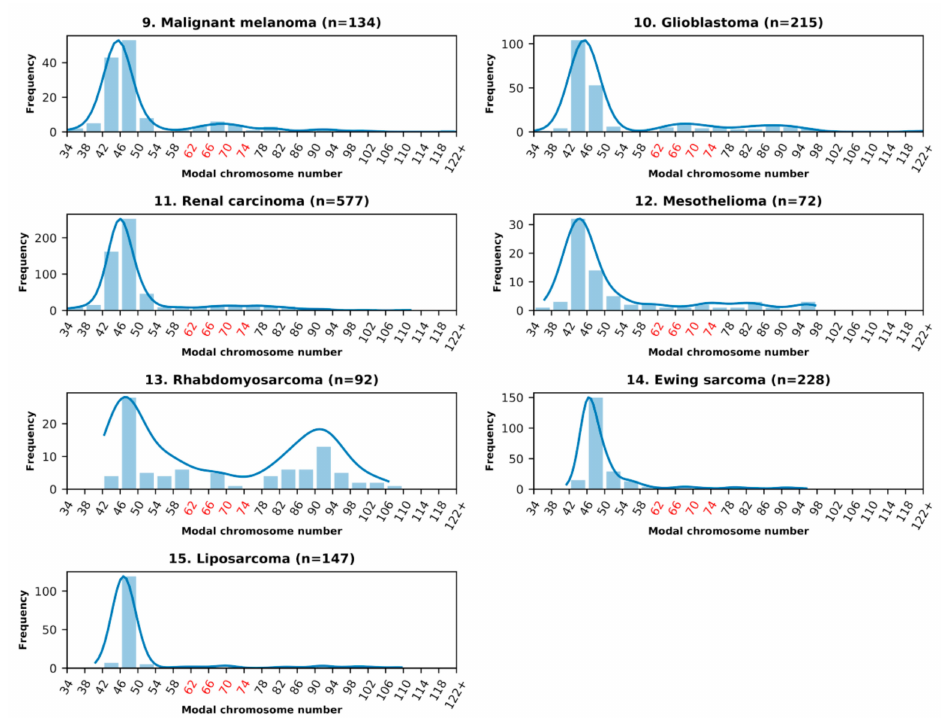
Figure 1. The modal chromosome number frequency histograms of 15 malignant tumor cohorts, numbered as listed in Table 1. The chromosome numbers within the (arbitrarily chosen) range of near-triploidy (62–76 chromosomes) are marked